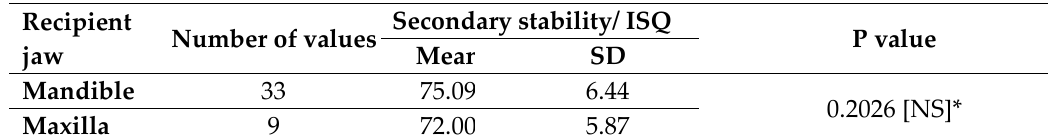
Abbreviations: ISQ, Implant stability quotient; SD, Standard deviation; S, Significant; *, Unpaired t-